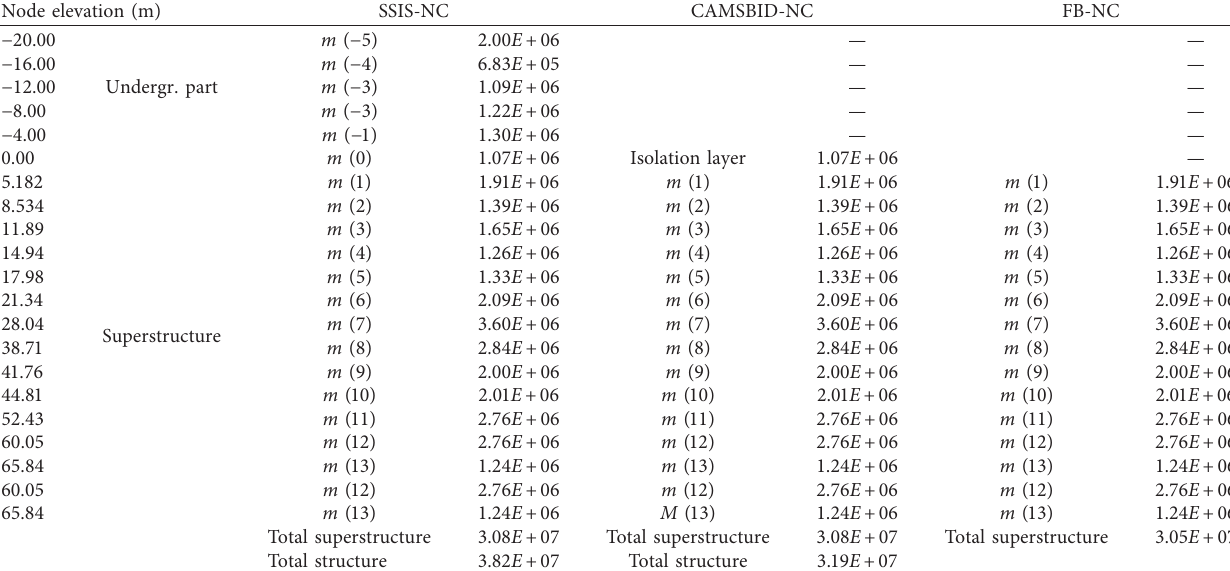
Table 2: Distribution of the masses for SSIS-NC, CAMSBID-NC, and FB-NC structures. Node elevation (m)